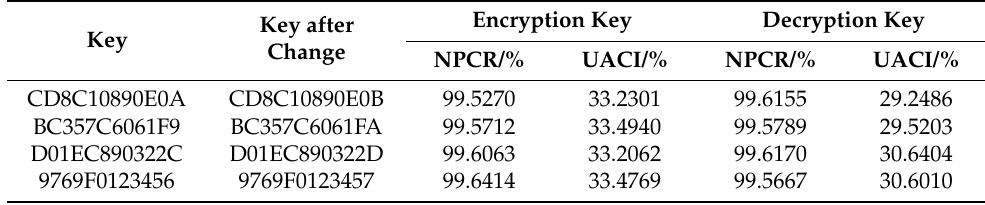
Table 7. Key sensitivity test results.